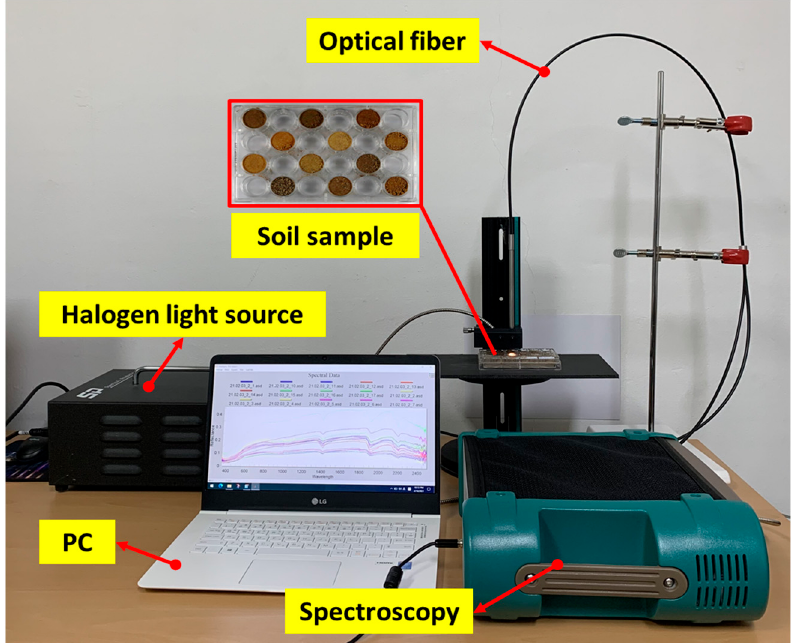
Figure 3. Experimental equipment setup for spectral spectrum acquisition of topsoil samples.